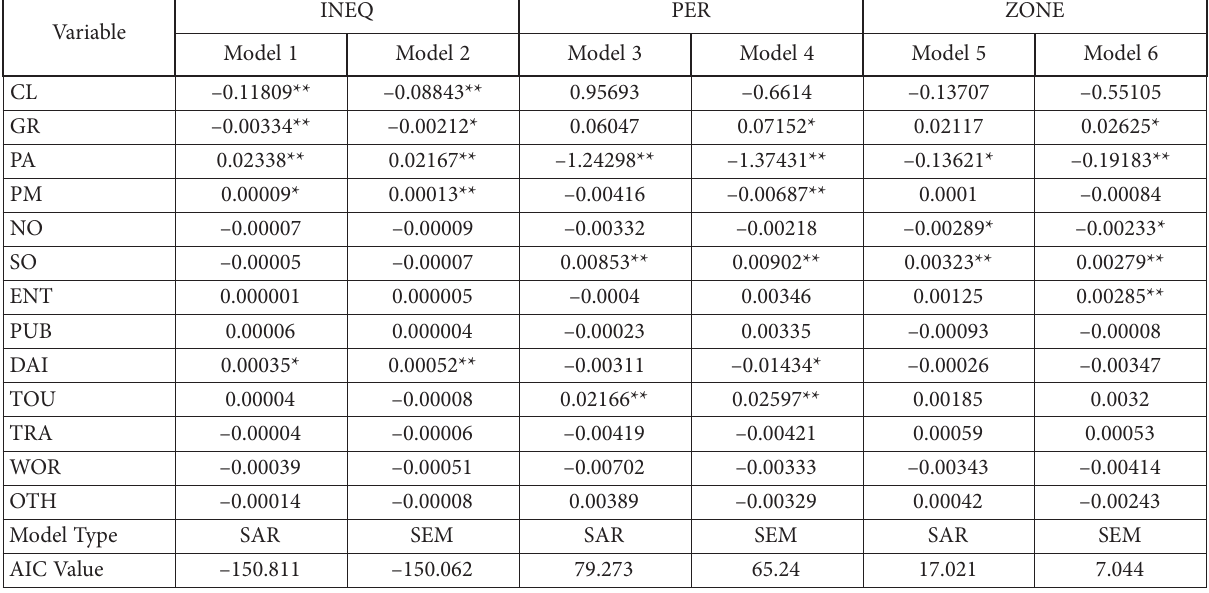
Table 5. Parameter estimation result of global regression